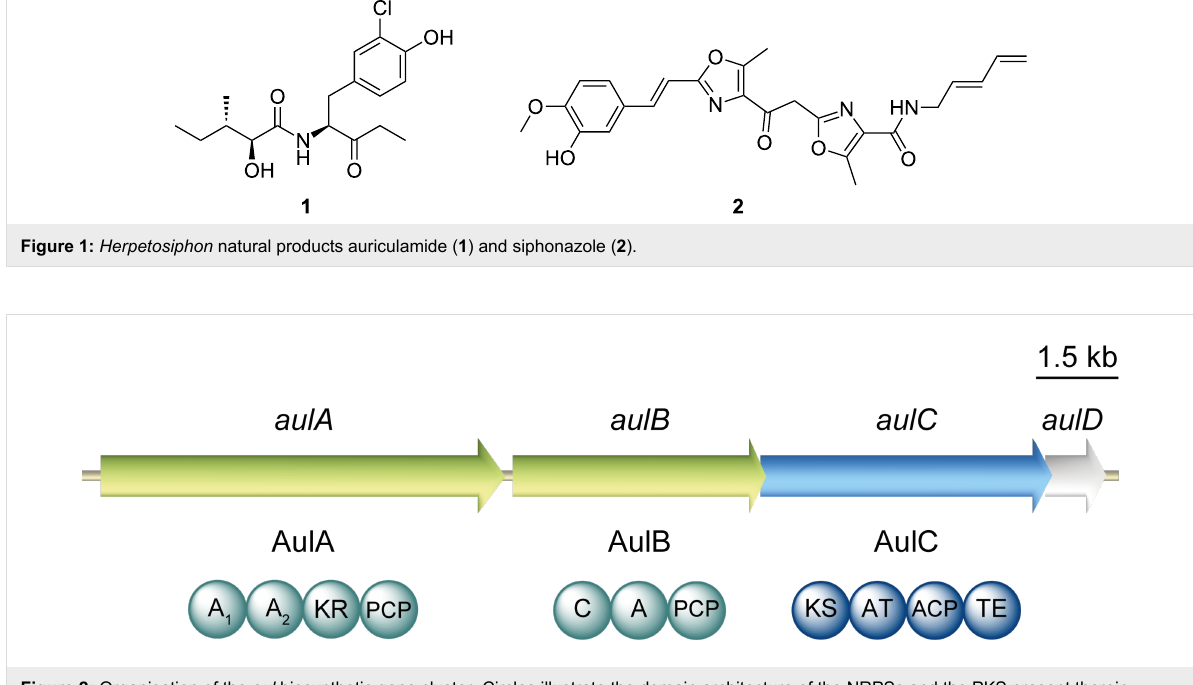
Figure 2: Organisation of the aul biosynthetic gene cluster. Circles illustrate the domain architecture of the NRPSs and the PKS present therein. Domains are abbreviated as A, adenylation; ACP, acyl carrier protein; AT, acyl transferase; C, condensation; KR, ketoreductase; KS, ketosynthase; PCP, peptidyl carrier protein; TE, thioesterase. The gene aulD encodes a type II